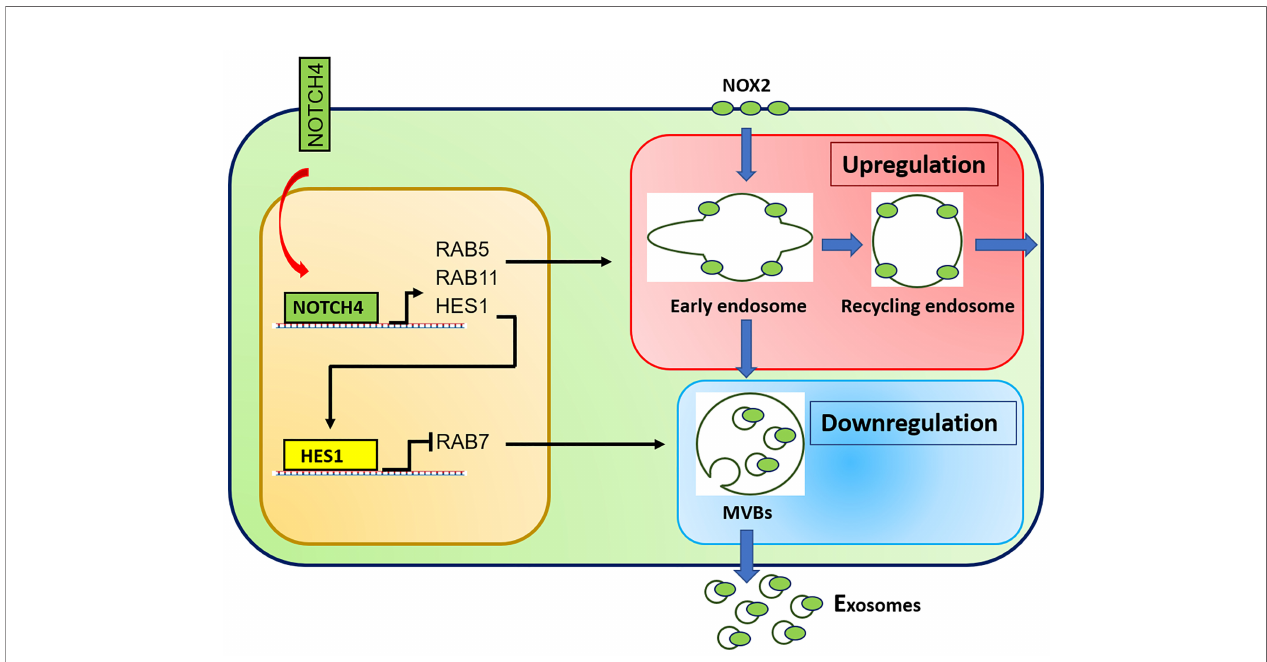
FIGURE 2 | Molecular defects in CD8 + Treg cells from GCA patients. Aberrant NOTCH4 signaling in GCA CD8 + Treg cells enhances expression of RAB5A and RAB11A and suppresses expression of RAB7A through HES1. RAB5A and RAB11A high expression promotes formation of early and recycling endosomes, keeping NOX2 in an intracellular, non-secretory storage compartment. RAB11 suppression results in de fi cient generation of specialized endosomes, the multivesicular bodies (MVB) and subsequent reduction in exosome biogenesis. Consequently, NOX2 is trapped intracellularly and no longer available to be loaded into immunosuppressive